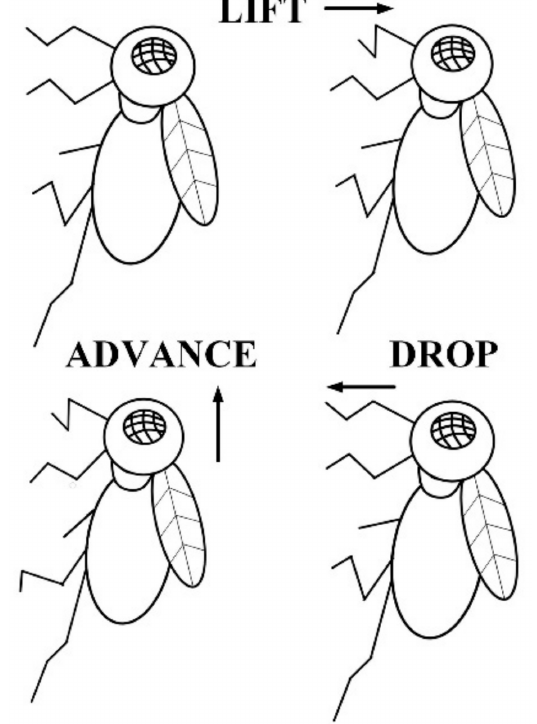
Figure 1. Locomotion of